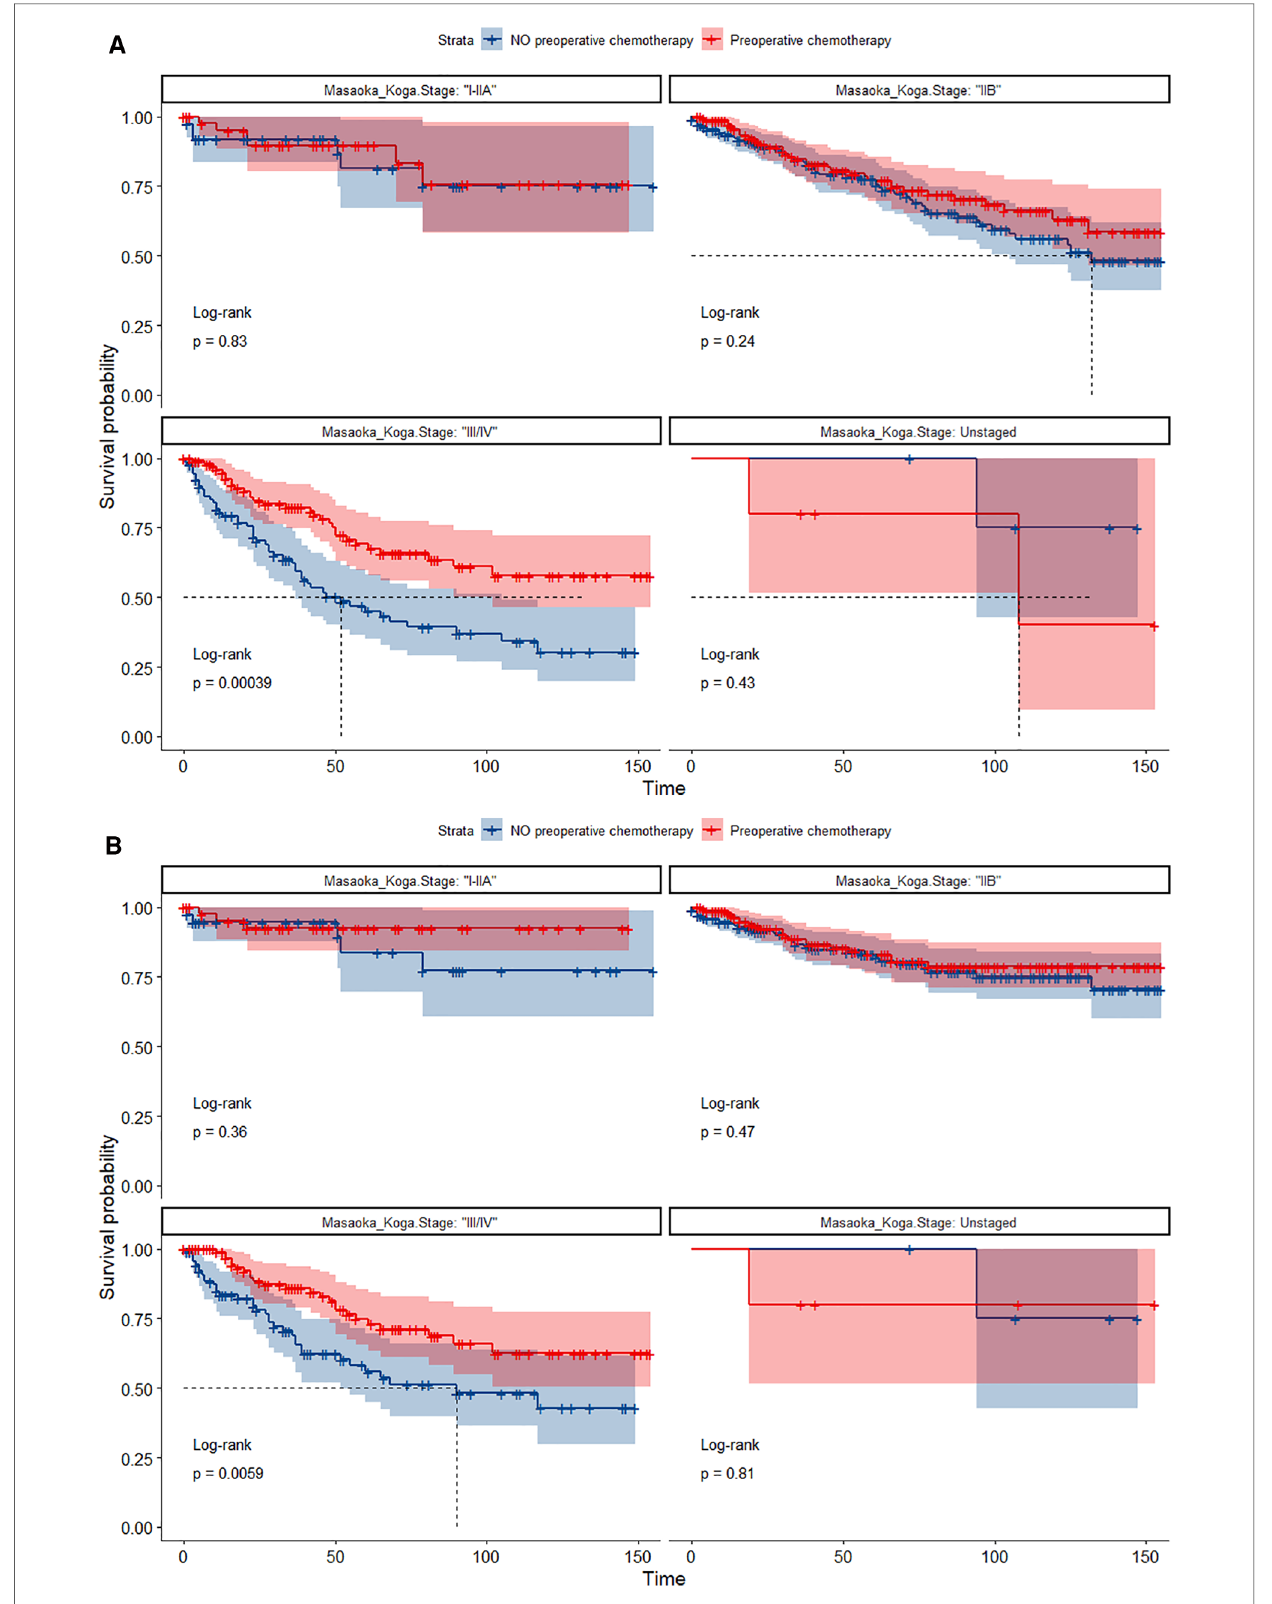
FIGURE 8 ( A ) Survival curves of OS in the POCT group and no-POCT group in patients undergoing surgery for TETs at different stages after propensity matching. ( B ) Survival curves of CSS in the POCT group and no-POCT group in patients undergoing surgery for TETs at different stages after propensity